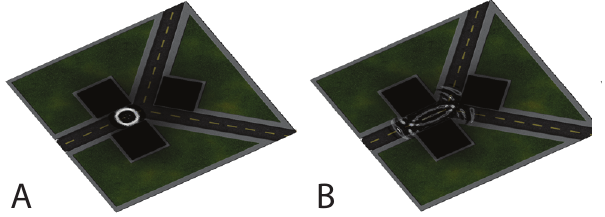
Fig. 9: Test scene geometry and the wave propagation effect evolving through time (from A to B). Parts (A) and (B) omit buildings to help in visualizing wave